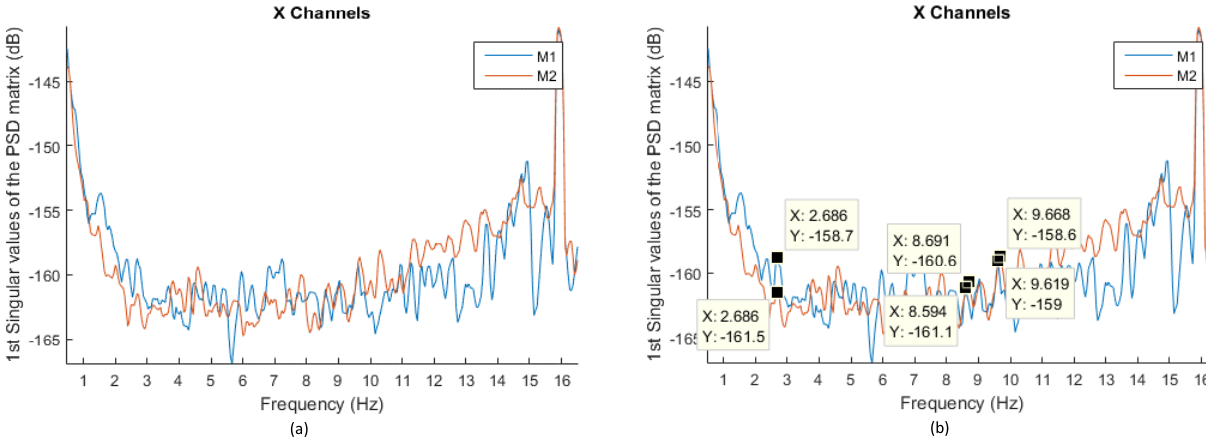
Figure 19. Comparison between the PSD of X channels of the two measurements. ( a ) General comparison. ( b ) Selected peaks.